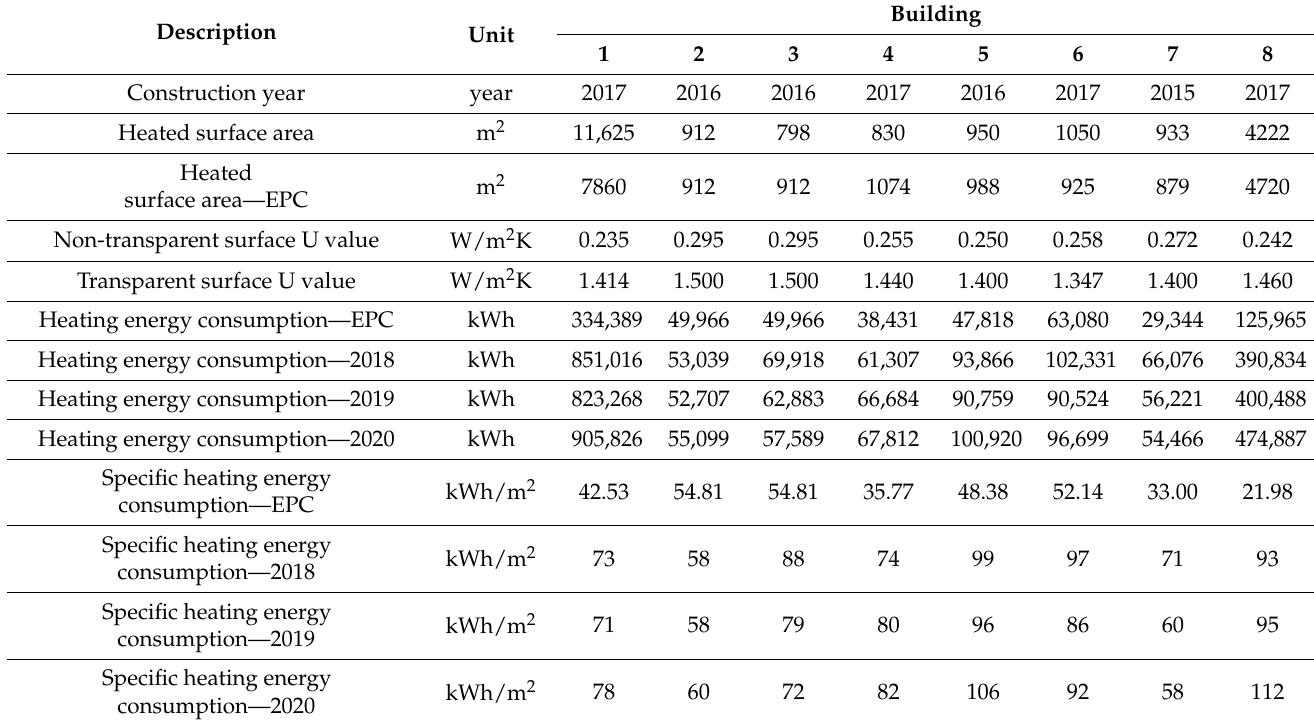
Table 4. Selected buildings with only IGB